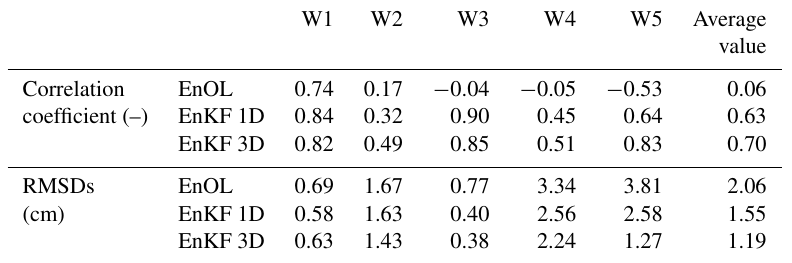
Table 4. Statistical values of the GWSV computed from the in situ well measurement and GRACE DA estimates between January 2007 and December 2010. The average values are computed by averaging the estimated statistical values from all well locations. W1